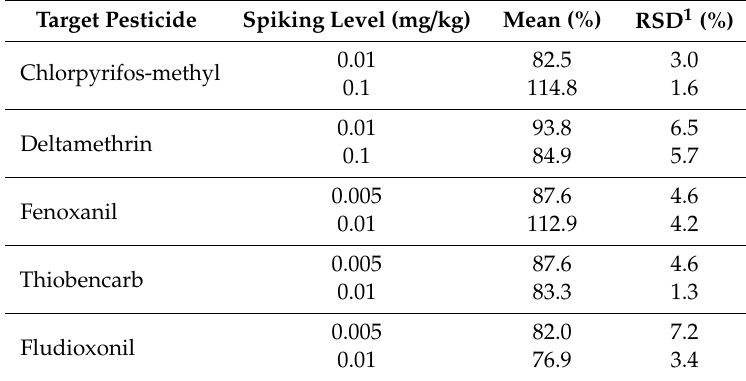
Table 2. Recoveries of each pesticide at two spiking levels. Target Pesticide Spiking Level (mg / kg) Mean (%) RSD 1 (%) Chlorpyrifos-methyl